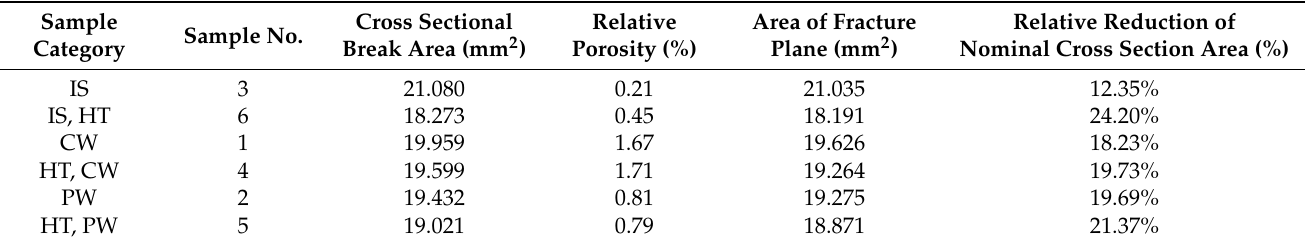
Table 8. Cross sectional area, relative porosity and relative reduction of the nominal cross section area depending on the sample state: L-PBF initial state (IS), heat treated HT, CW polished (CW), heat treated and CW polished (HT, CW), PW polished and heat treated and PW polished (HT, PW).